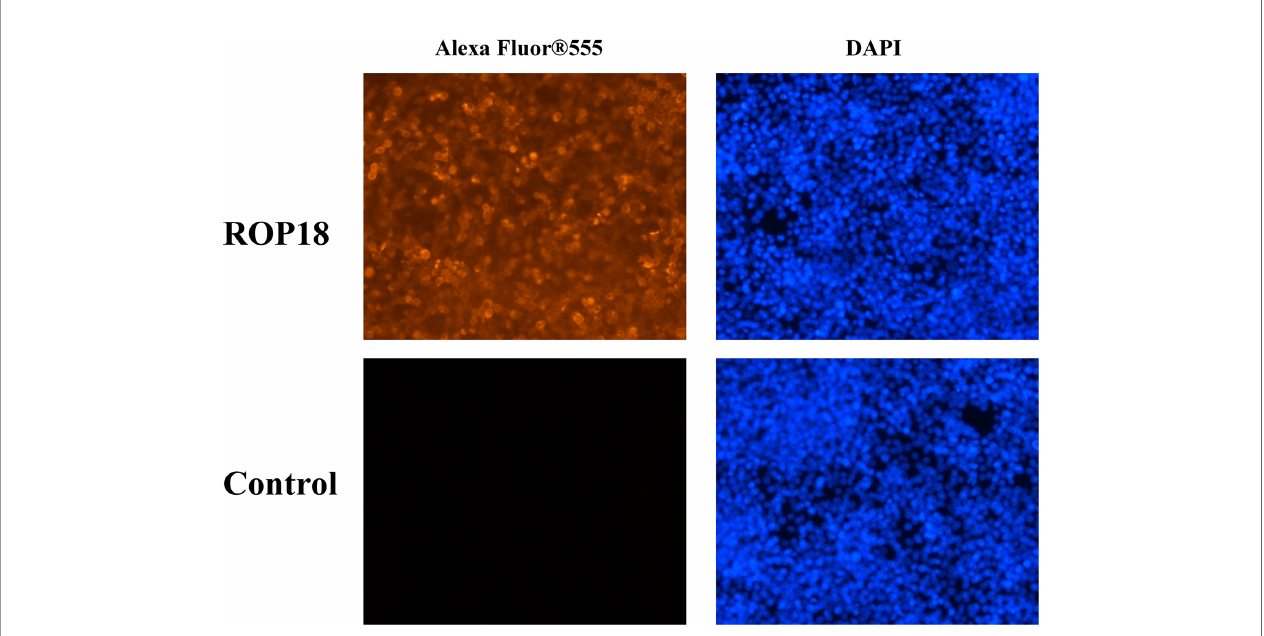
FIGURE 1 | Indirect immuno fl uorescence of the transfected HEK293T cells. The ROP18 protein tagged with HA was stained with AlexaFluor 555 (Orange) and the nucleus was counterstained with DAPI (Blue). The HEK293T cells transfected with PCMV-N-HA-ROP18 showed high density of orange signal, whereas HEK293T cells transfected with PCMV-N-HA did not show any fl uorescent